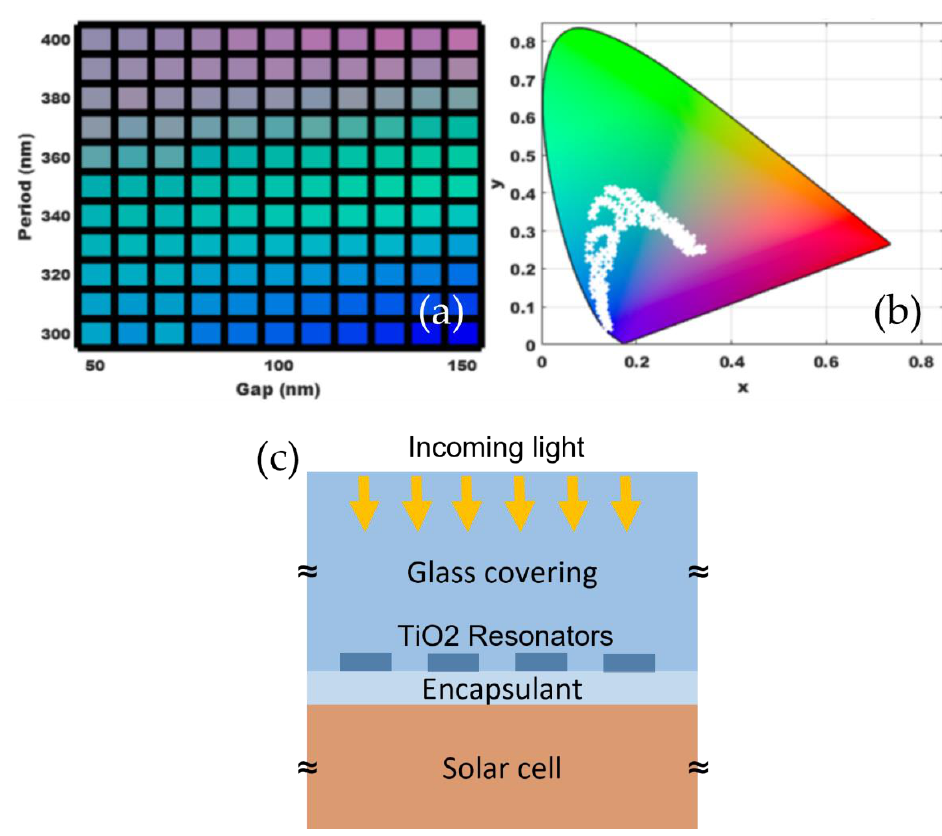
Figure 6. ( a ) Color palette generated from TiO 2 disk resonators (embedded in silica layer) of height 200 nm for different combinations of array period and gaps. ( b ) Corresponding positions of the colors on the CIE 1931 chromaticity diagram. ( c ) A schematic describing TiO 2 resonator array on top of encapsulated of a solar cell and embedded within a glass covering. Note that, in the simulations, the refractive of the medium around the TiO 2 resonators is assumed to be the same as that of silica layer (n = 1.46), as the refractive indices of glass covering and the encapsulant are similar. The light is the incident form of the silica glass (n = 1.46) medium.